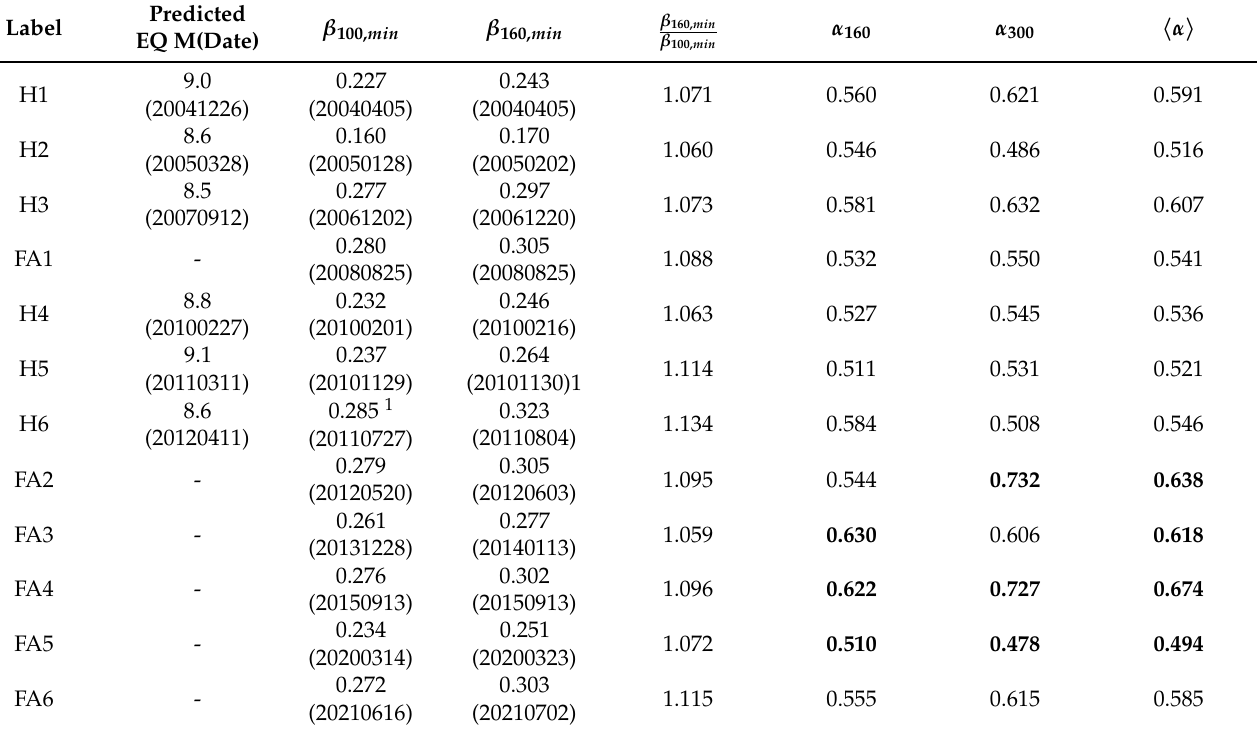
Table 1. The ‘precursory’ fluctuation minima, i.e., the variability minima that satisfy Conditions (10) and (11), together with DFA exponents α 160 , α 300 , and their mean value (cid:104) α (cid:105) . The exponents typed boldface lie outside the range defined by the corresponding exponents estimated for the precursory variablility minima that preceded all EQs with M ≥ 8.5. For each row, a label is also inserted to express whether it is a hit (H1 to H6) or a false alarm (FA1 to FA6). For the hits, a brief reference to the predicted M ≥ 8.5 EQ is inserted in the corresponding column, for more details, see Table